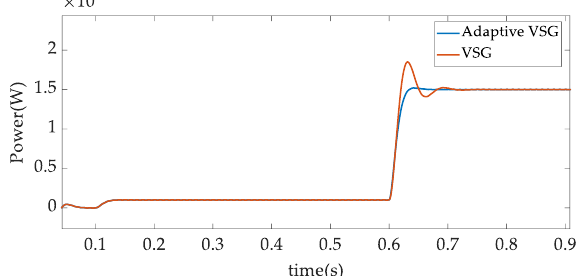
Figure 9. Output power of the MMC-RPC under two VSG controls.